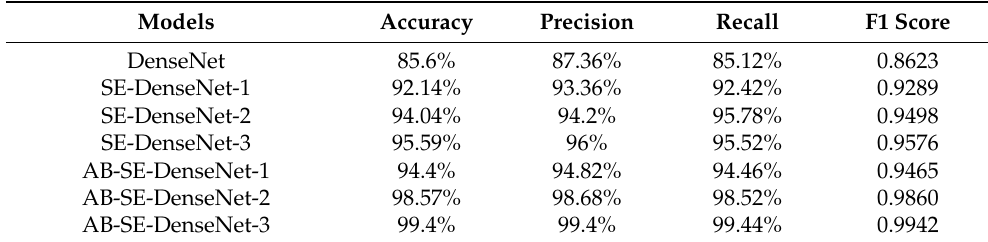
Table 3. Recognition performance table of each model.